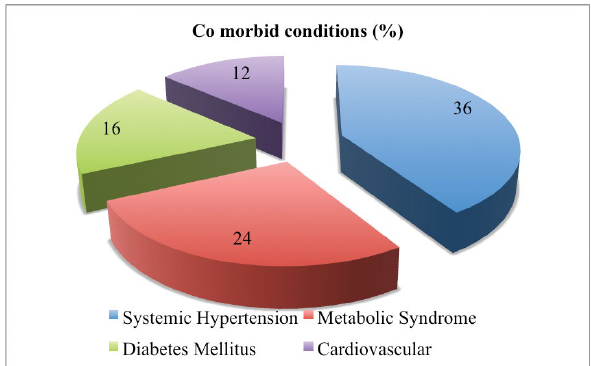
Figure 2: Comorbidities associated with patients presenting with Respiratory Symptom